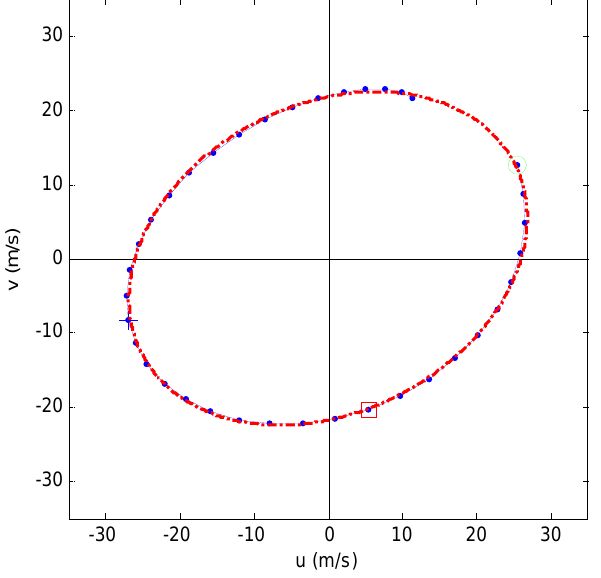
Table 5. Results of hodograph analysis corresponding to each wave